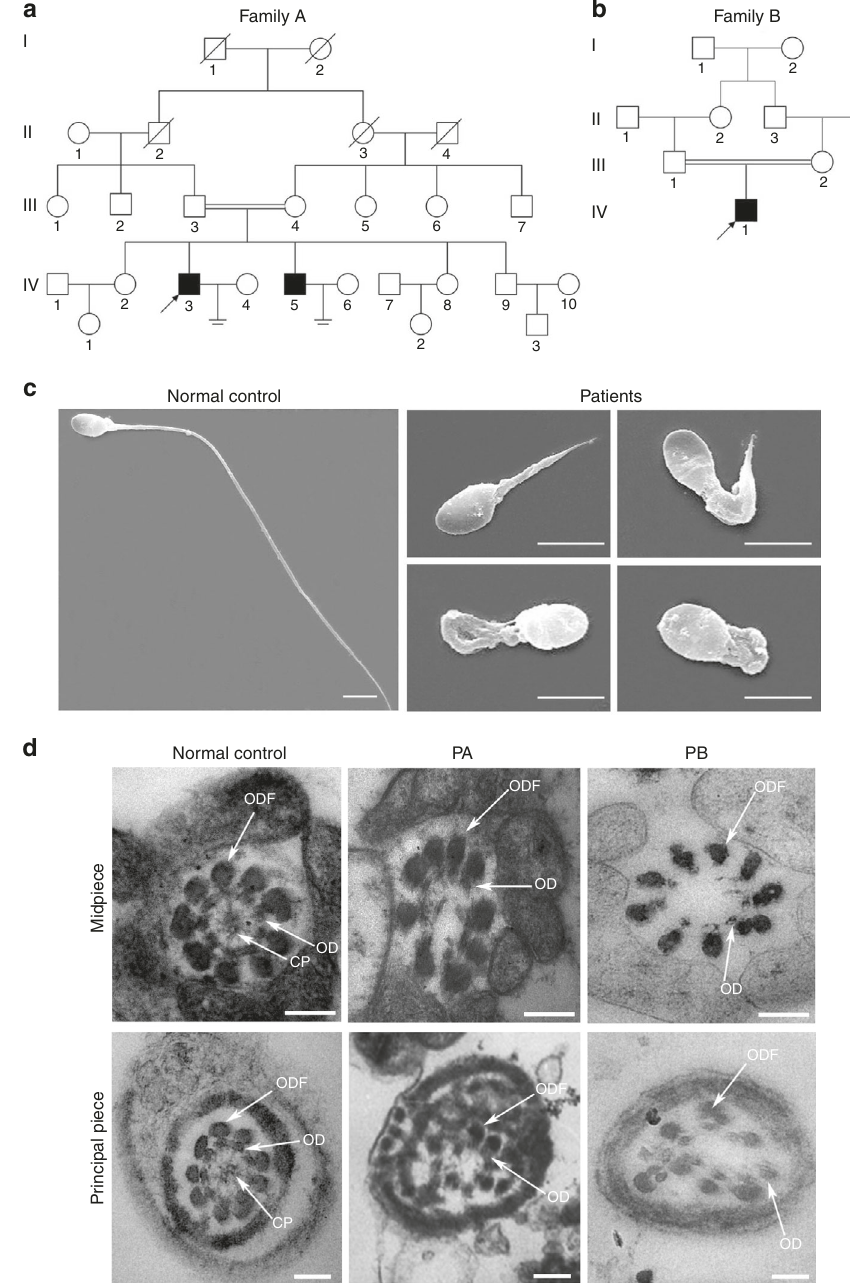
Fig. 1 Sperm morphology and ultrastructure in the two MMAF patients. a , b The pedigree structure and segregation analysis in two families. Squares represent male pedigree members, circles represent female pedigree members, solid symbols represent members with MMAF, and open symbols represent unaffected members; the probands are indicated by black arrows. c The malformations of sperm fl agella in the two MMAF individuals. The absent, short, thick, or coiled fl agella and other MMAF phenotypes were observed in two patients compared with the normal control by SEM (scale bars, 5 µ m). d The abnormal ultrastructures of the mid-piece and principal piece of sperm fl agella in two patients. By TEM, in the mid-piece, PA exhibited an atypical 9 + 0 arrangement of axonemal microtubules, and the CP and OD defects were observed in PB. The principal piece of the PA and PB fl agella consist of incomplete and disorganized OD and ODF and lack CP. Fibrous sheaths were not apparent, especially for PB. (scale bars, 100